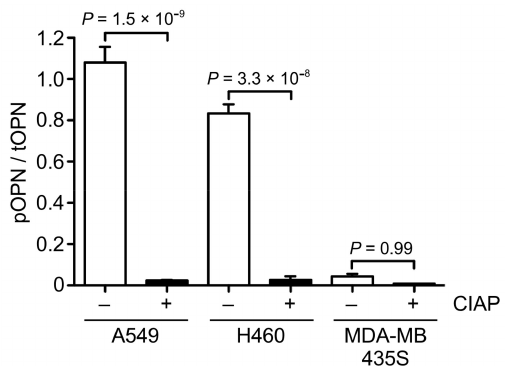
Figure 4. Quantitative analysis of the ratio of phosphorylated to total OPN in the CM of cancer cells. The CM of A549, H460, and MDA-MB435S cancer cells were treated with or without calf intestine alkaline phosphatase (CIAP) and were then subjected to phos-tag ELISA. Two-tailed unpaired